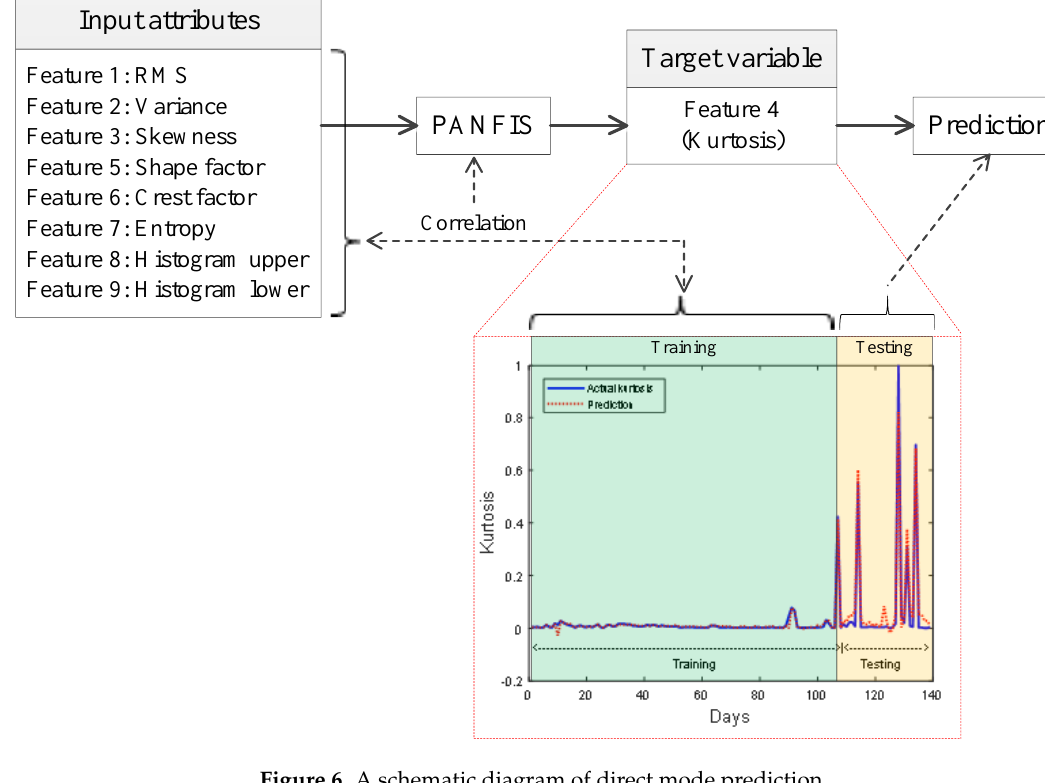
Figure 6. A schematic diagram of direct mode prediction.